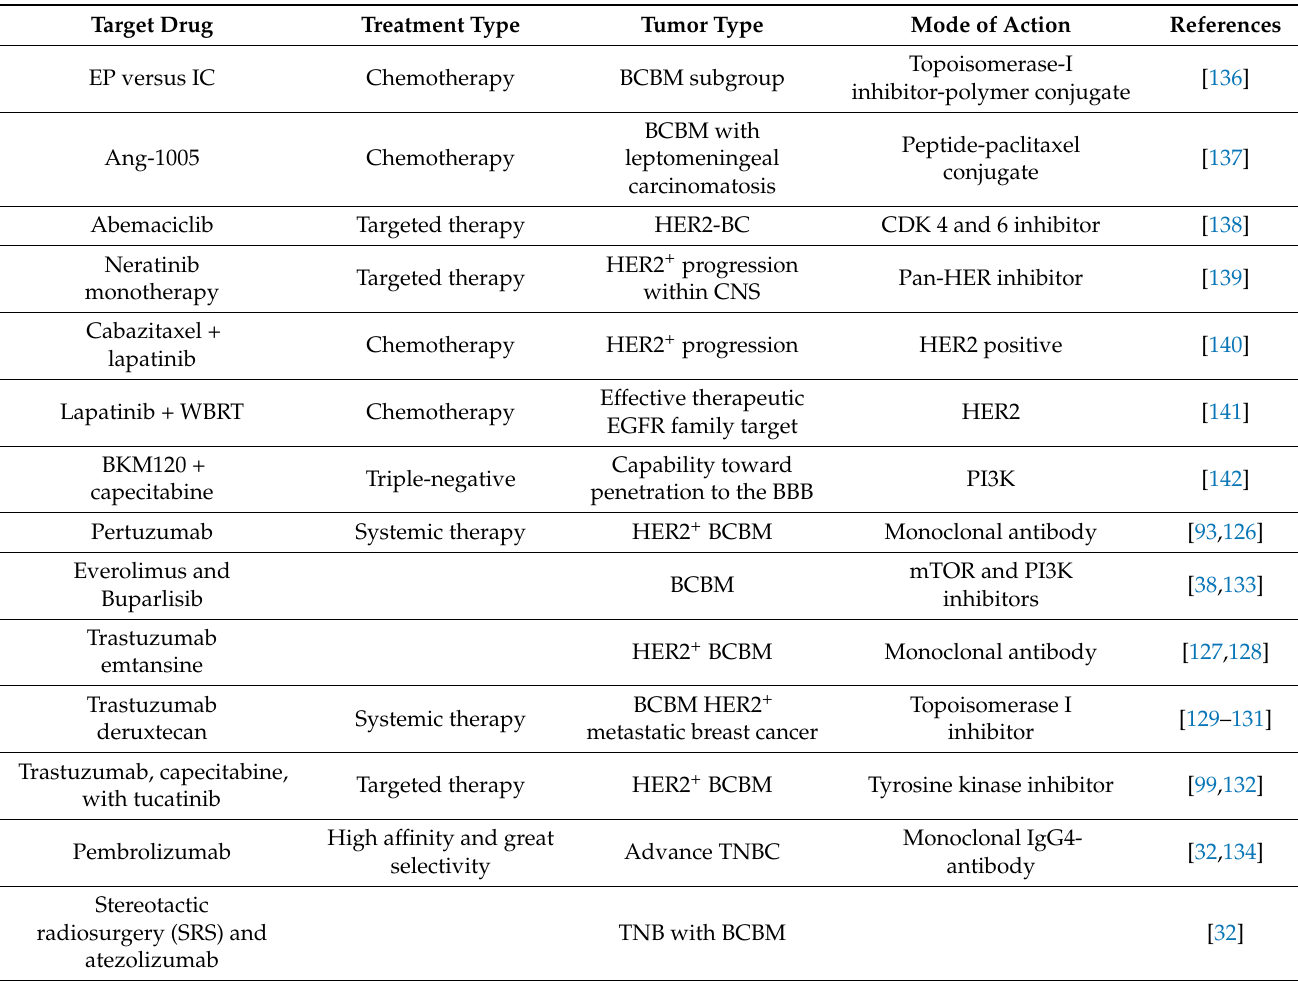
Table 2. Current/clinical trial drugs and their mechanism of action against brain metastatic disease in